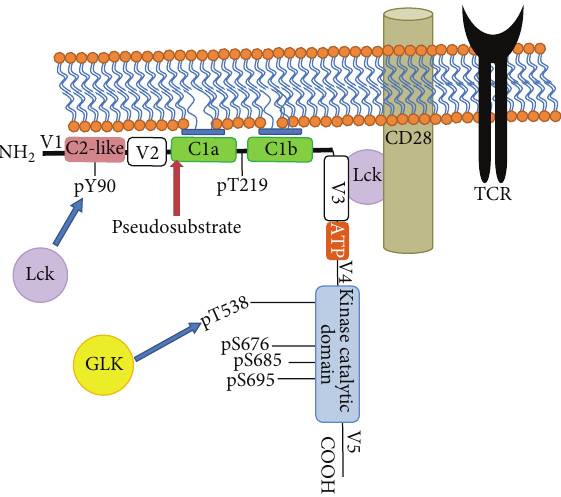
Figure 1: A schematic model of membrane-associated PKC 𝜃 in TCR/CD28 stimulated T cells. Regulatory N-terminal domain consists of V1, C2-like, V2, C1a, C1b, and V3 domains. Catalytic C- terminal domain consists of ATP binding site, V4, kinase catalytic domain (substrate binding site), and V5. PKC 𝜃 binds to the mem- brane through diacylglycerol by its C1a and C1b domains. It interacts with CD28 via Lck through its V3 domain. Blue arrows represent phosphorylation by respective enzymes on specific amino acid residues. V: variable domain; C: constant domain; GLK: germinal center kinase- (GSK-) like kinase; Lck: Lymphoid cell kinase; TCR: T cell